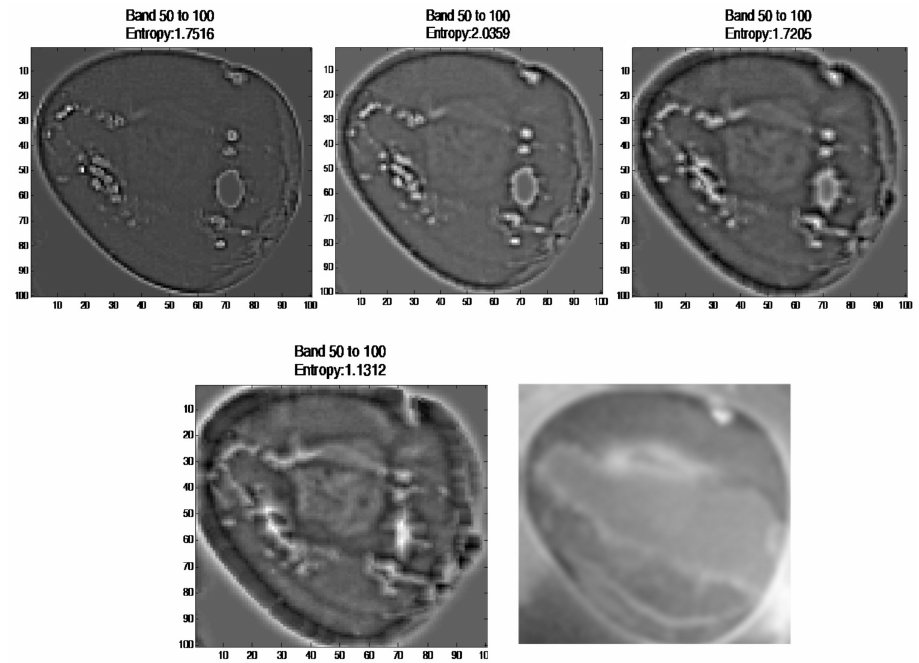
Figure 14. Output image at four different parameter sets ([5,5], [3 3], 0.1), ([15,15], [5 5], 0.1), ([25,25],